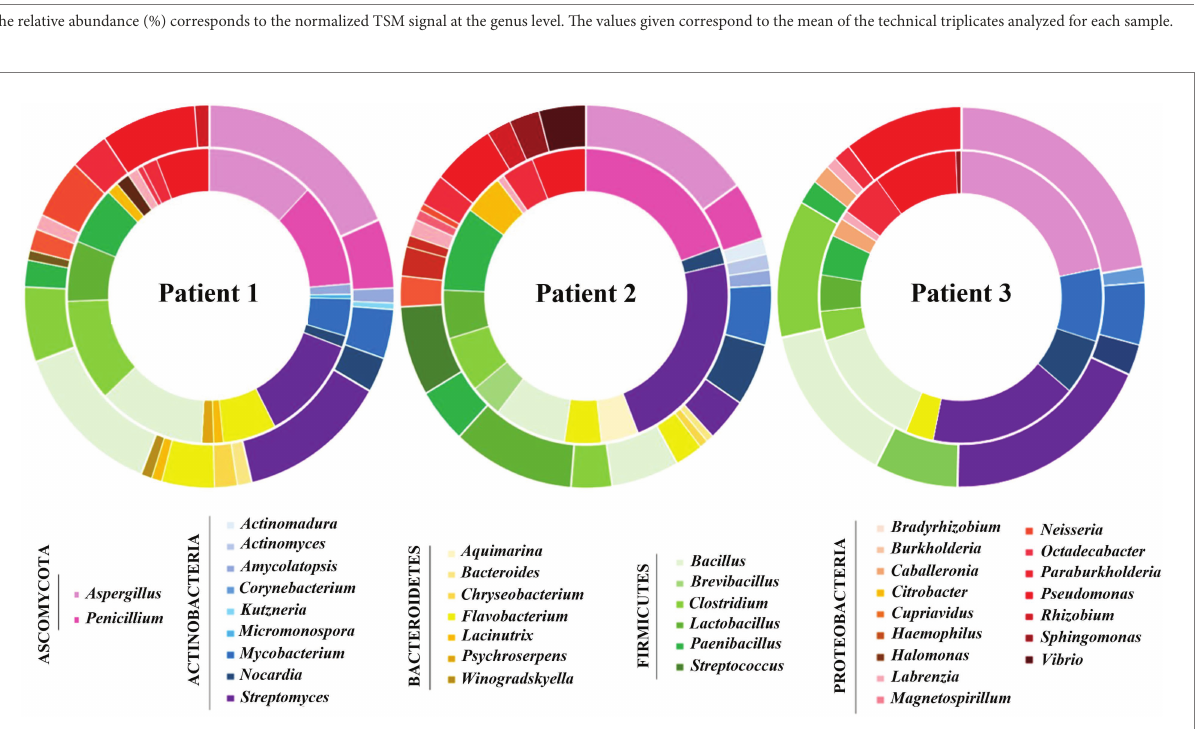
The relative abundance (%) corresponds to the normalized TSM signal at the genus level. The values given correspond to the mean of the technical triplicates analyzed for each sample.